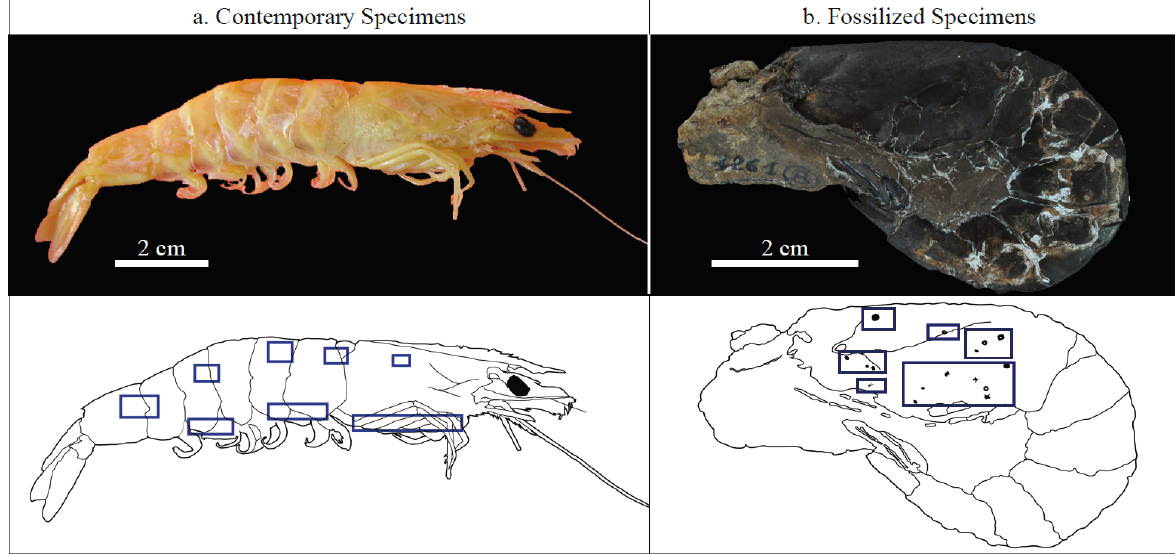
Figure 1. Images of the decapod materials hosting the investigated contemporary and fossilized epibiotic calcifying bacterial colonies. ( a ) Photograph and schematic representation of a contemporary specimen of Farfantepenaeus brevirostris (Kingsley, 1878, MNHN.IU. Na8524), from La Paz Bay, Mexico. ( b ) Photograph and schematic representation of a fossilized specimen of Aeger brevirostris Van Straelen, 1923 (MNHN.F.R61863) from the Callovian of La Voulte-sur Rhône. Blue squares indicate the location of epibiotic calcifying bacterial